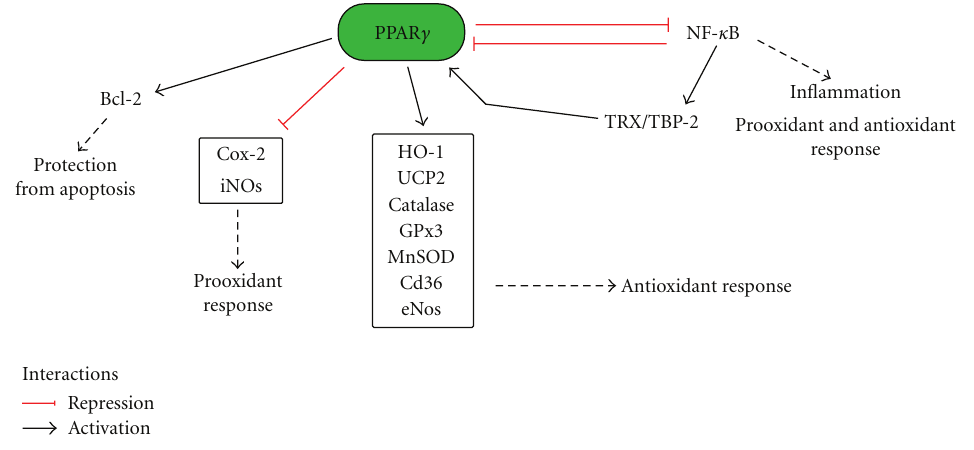
Figure 1: PPAR γ target genes and cellular roles. In oxidative stress conditions the nuclear receptor PPAR γ directly regulates a vast array of genes involved in the response to oxidative stress and exerts anti-inflammatory e ff ects transrepressing NF- κ B.